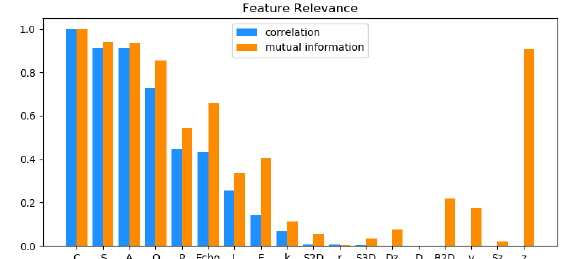
Figure 4. Relevance of features according to the correlation and mutual information values converted to 0 – 1 interval. See Table 1 for explanation of feature